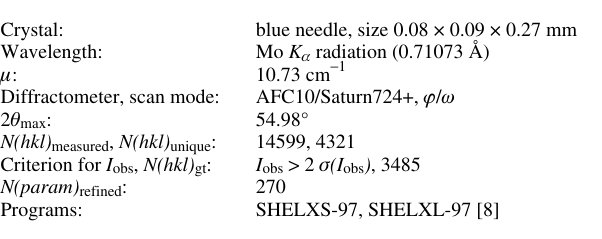
Table 1. Data collection and handling.